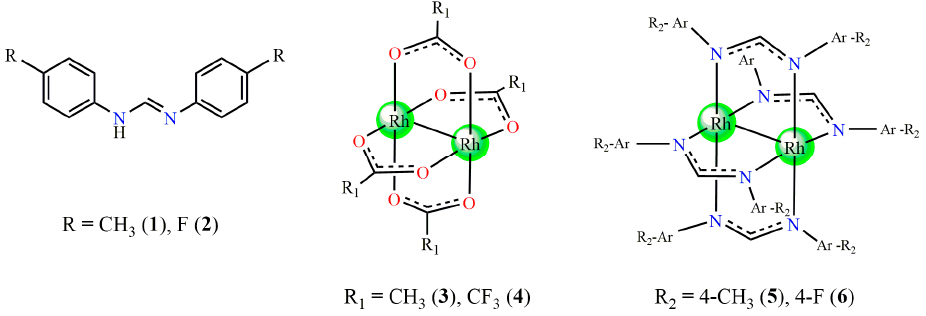
Figure 1. Structures of the ligands and dirhodium(II, II) complexes ( 1 – 6 ) [29].